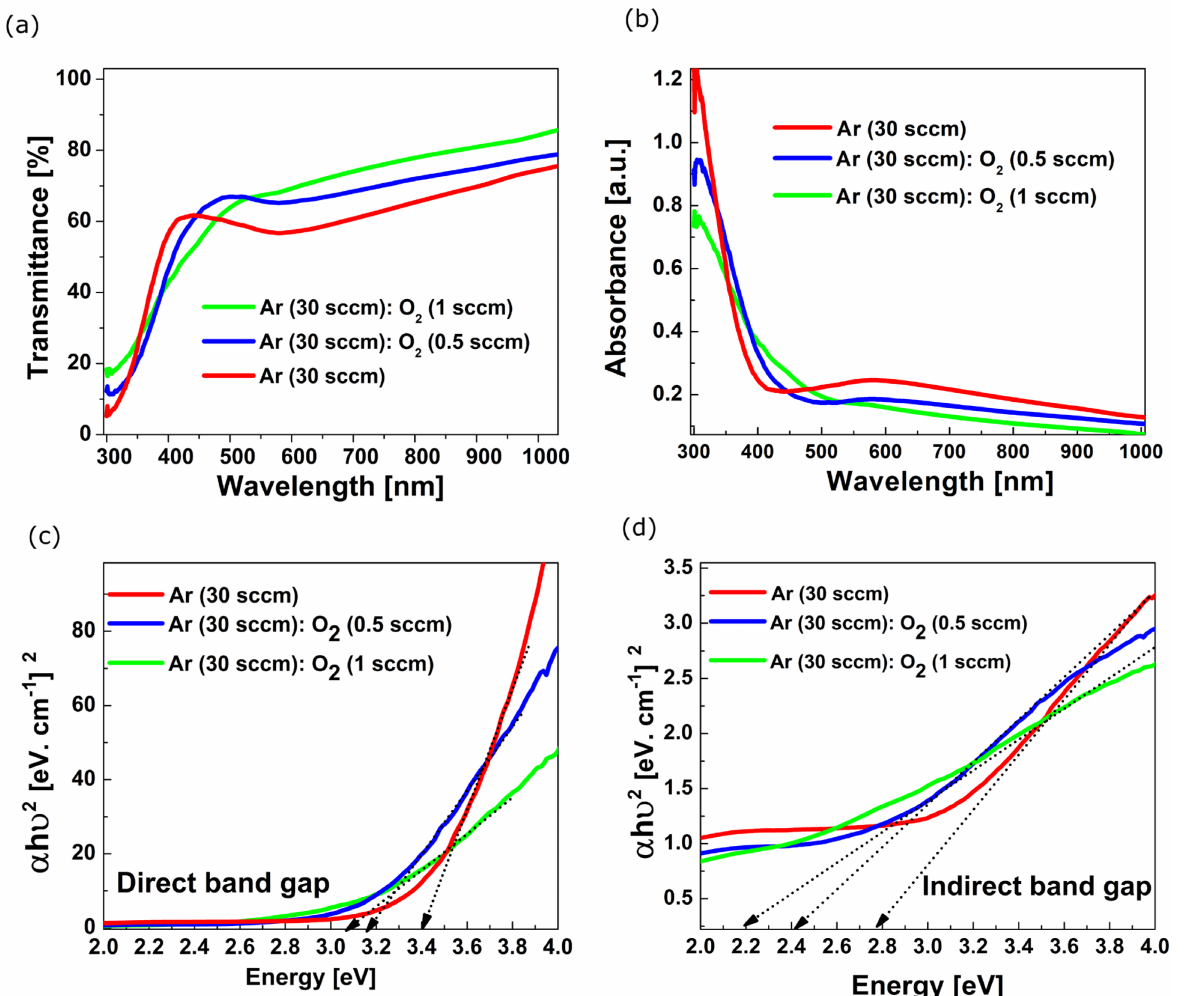
Figure 3. Transmission ( a ) and absorption ( b ) graphs of the films deposited at different concentrations Ar:O 2 . Direct ( c ) and indirect ( d ) band gap